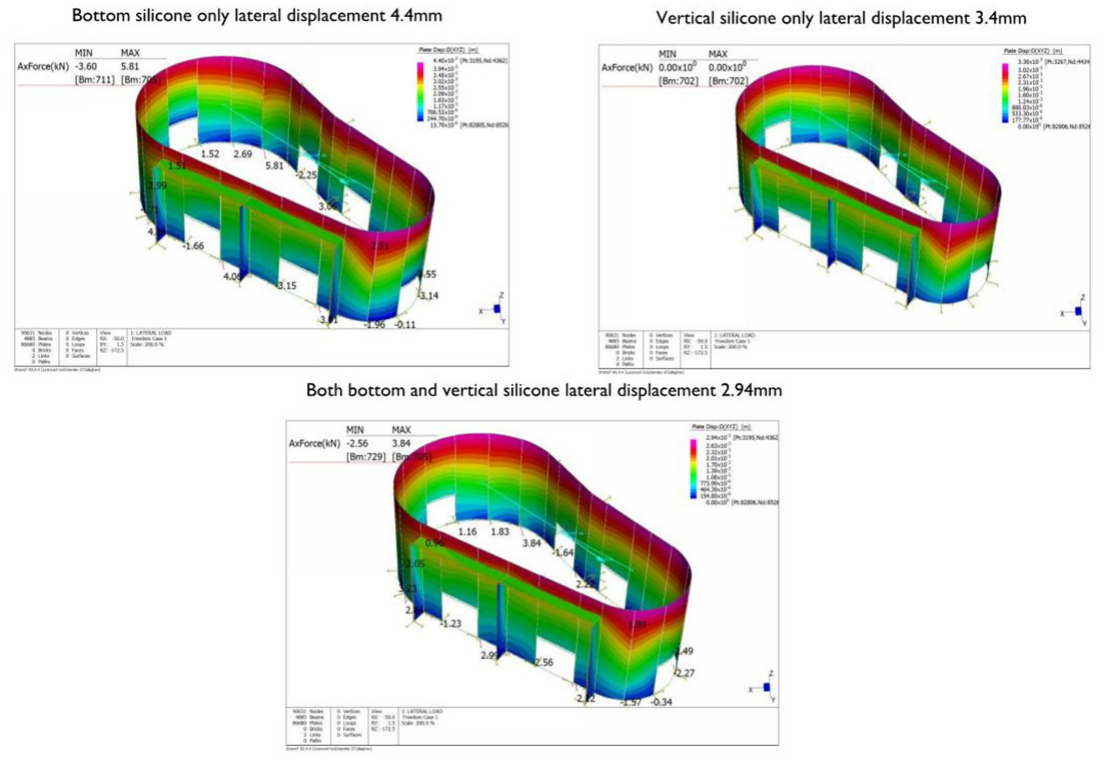
Fig. 12 Global lateral deflection of independent stability